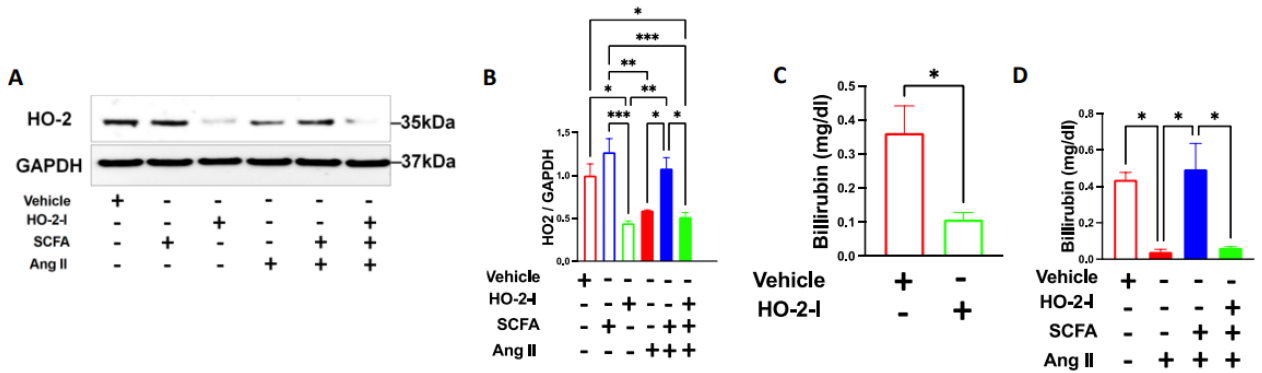
Figure 1. SCFAs rescue HO-2 after Ang-II treatment. Immunoblots ( A ), quantifications ( B ), and bilirubin assay ( C , D ) showing that the Ang-II-induced reduction in HO-2 protein expression and activity in brain microvascular endothelial cells was rescued by the SCFAs/HO-2 axis. * p < 0.05; ** p < 0.01; *** p < 0.001. N = 3–4. SCFAs: short-chain fatty acids; Ang II: angiotensin II; and HO-2 I: heme oxygenase 2 inhibitor.